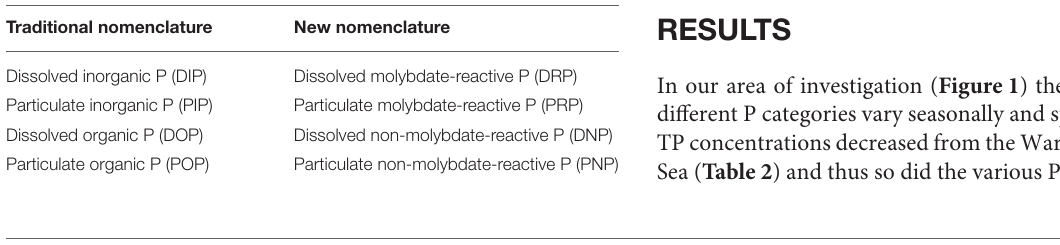
TABLE 2 | The variability of the concentration ranges of the phosphorus (P) fractions at the different stations of the study vs. that reported in the literature for different study areas.